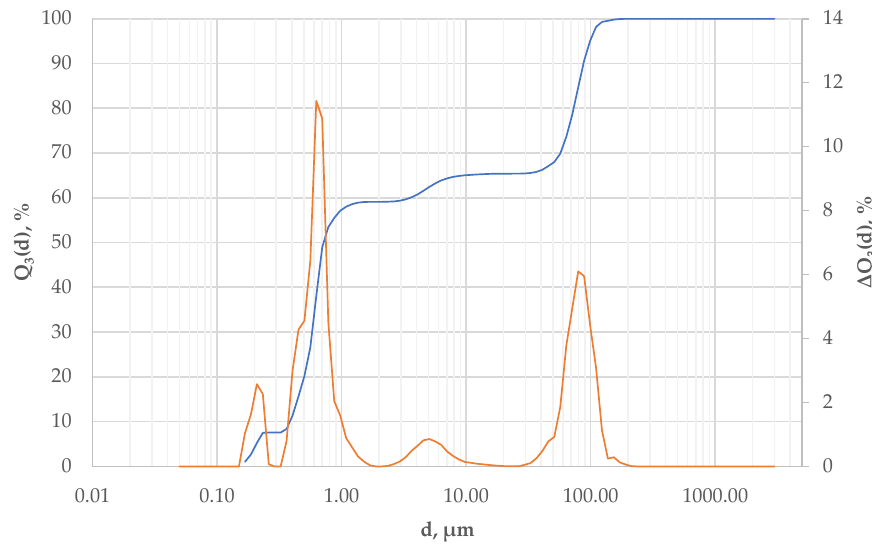
Figure A1. Particle size distribution for waste alumina powder. Table A1. Composition of prepared suspensions used in preliminary experiments.